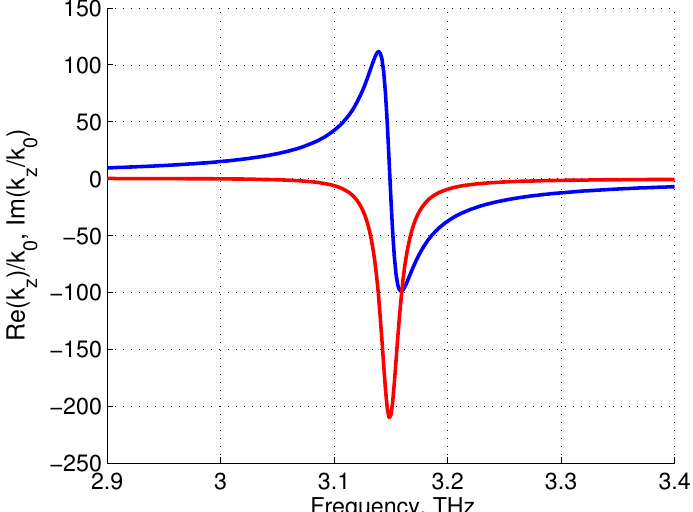
/k , calculated at E z 0